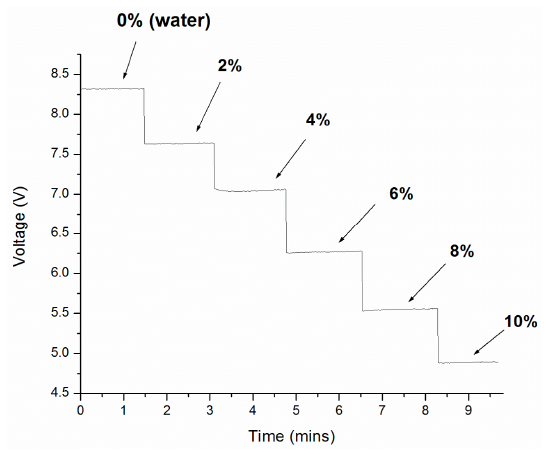
Figure 3. Real-time measurement results for different salt (sodium chloride) solutions ranged from